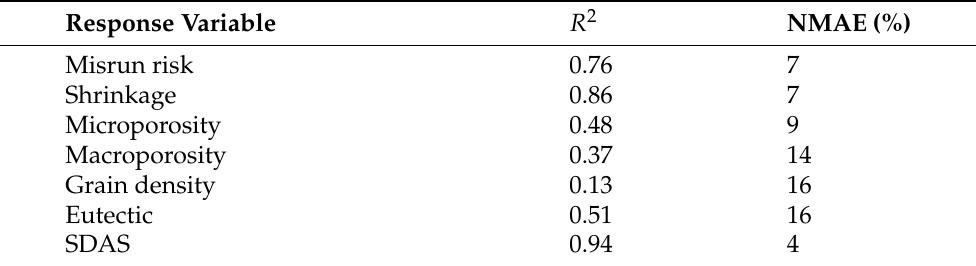
Table 4. Response